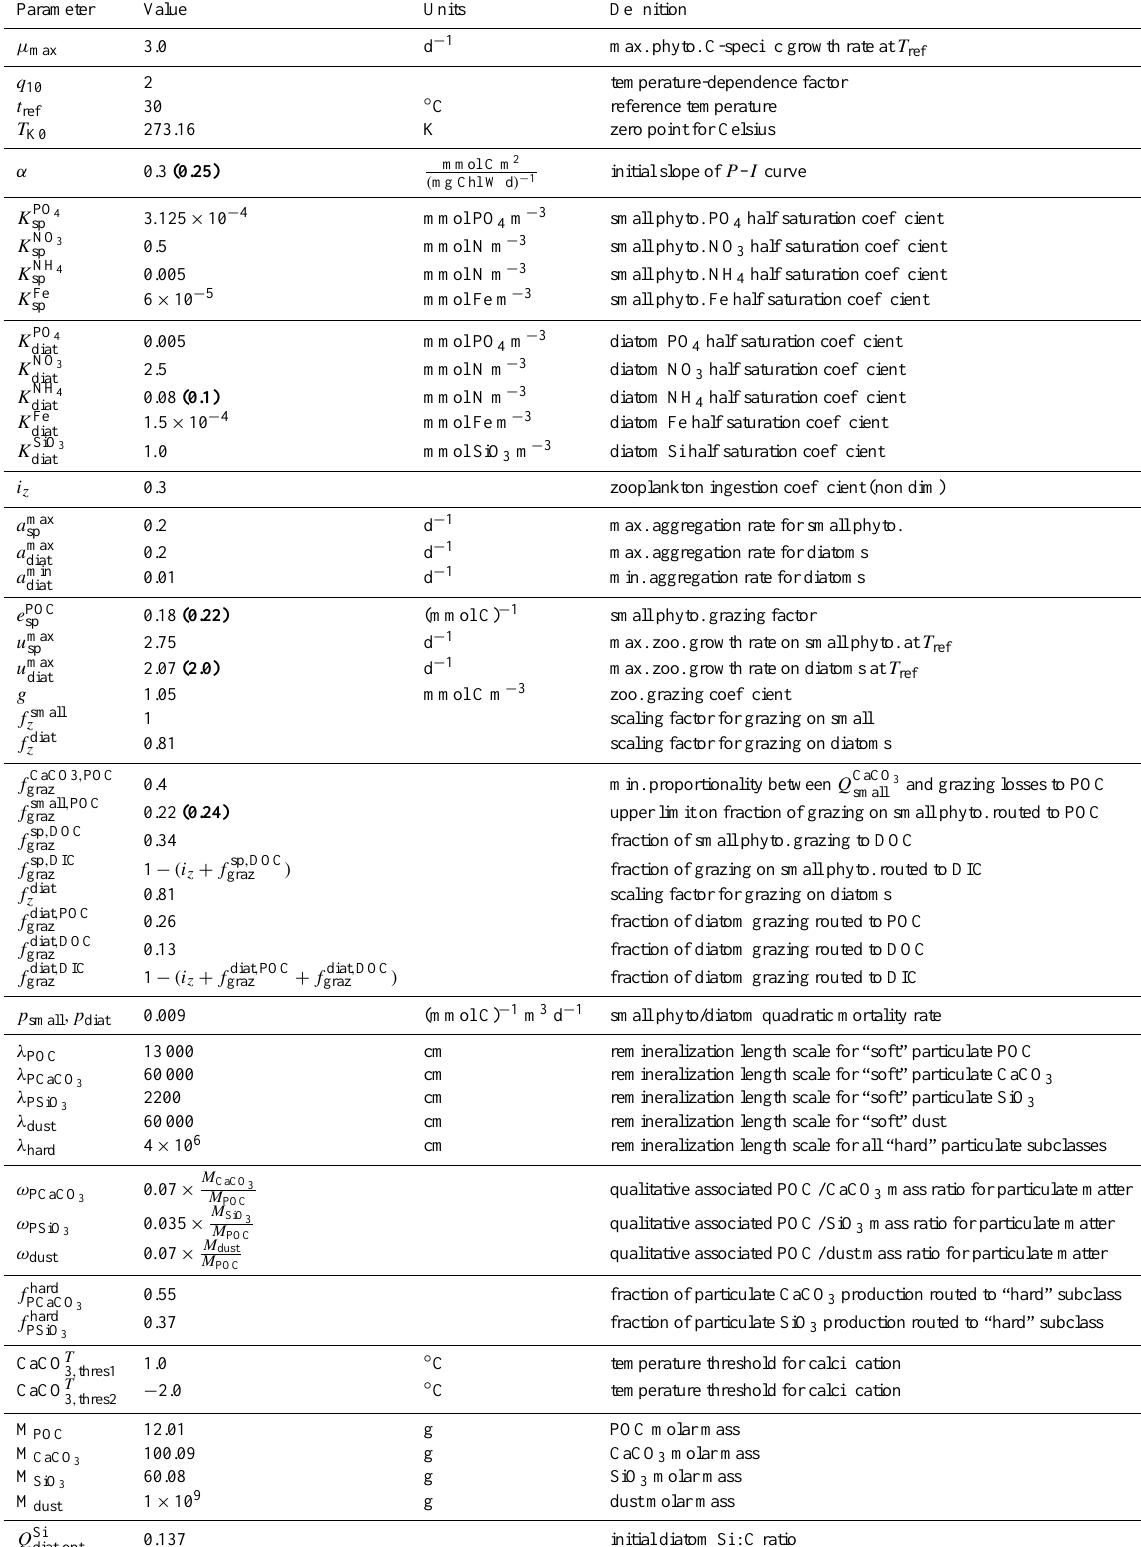
Table A1. Parameters of the ecosystem model BEC. Bold numbers in brackets denote values that have been used in the version of Doney et al.